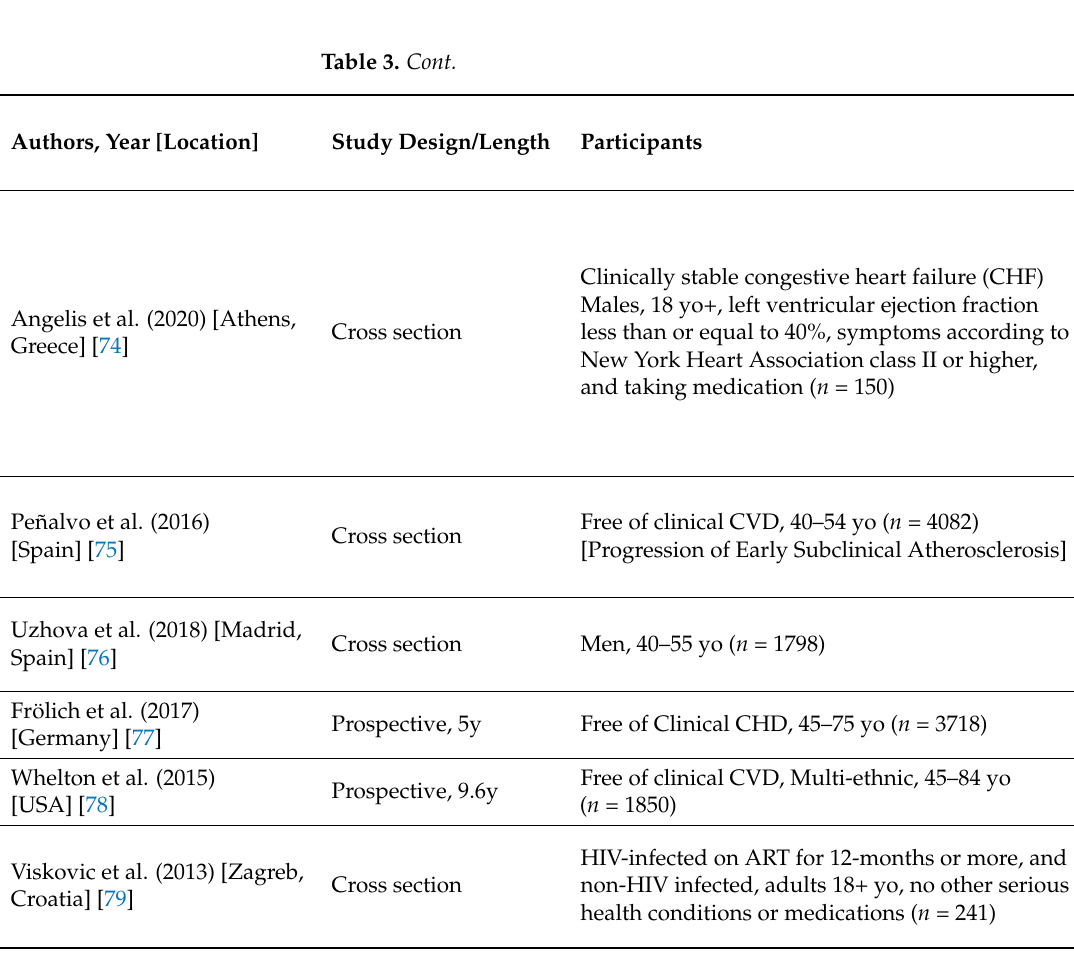
Table 2. Clinical